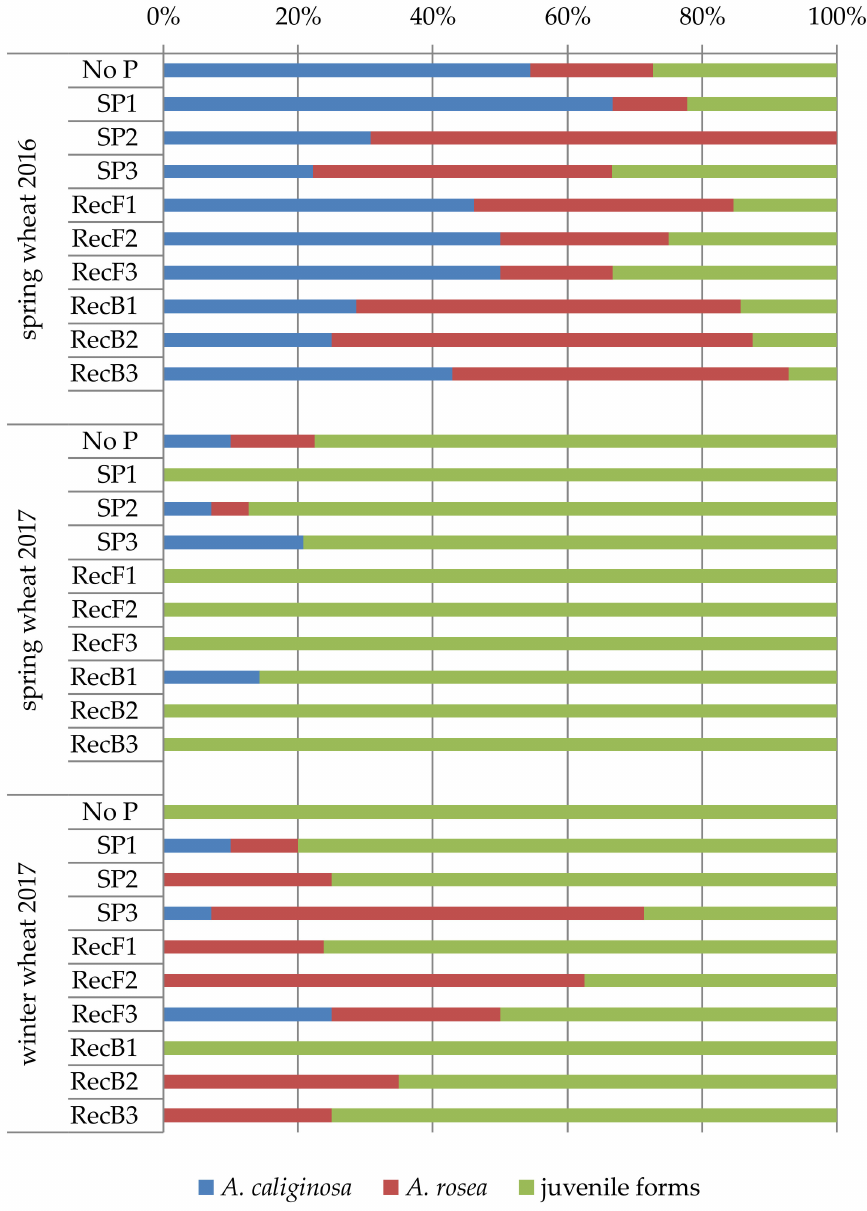
Figure 1. Species composition and structure of earthworms (based on the density of individuals). No significant di ff erences between treatments according to the Kruskal–Wallis test at p ≤